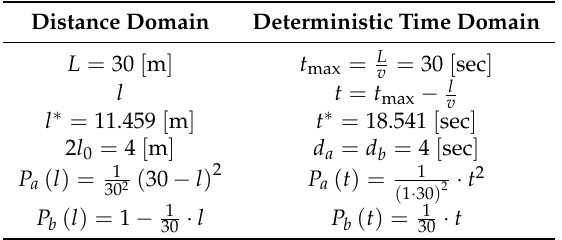
Table 1. Time domain transform of a classic duel game.